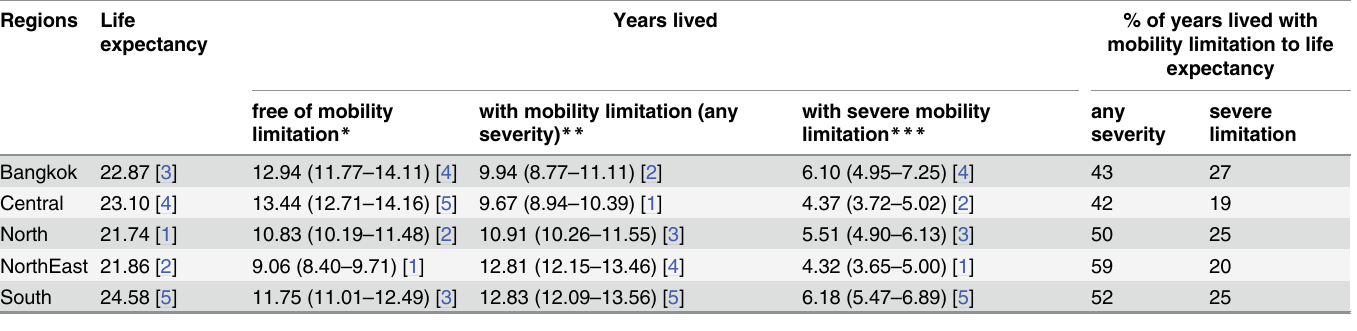
Table 5. Life expectancy, number of years lived in different states of mobility limitation (95%CI), and proportion of years lived with mobility limita- tion to life expectancy at age 60 for Thai females by regions, 2009. Regions Life